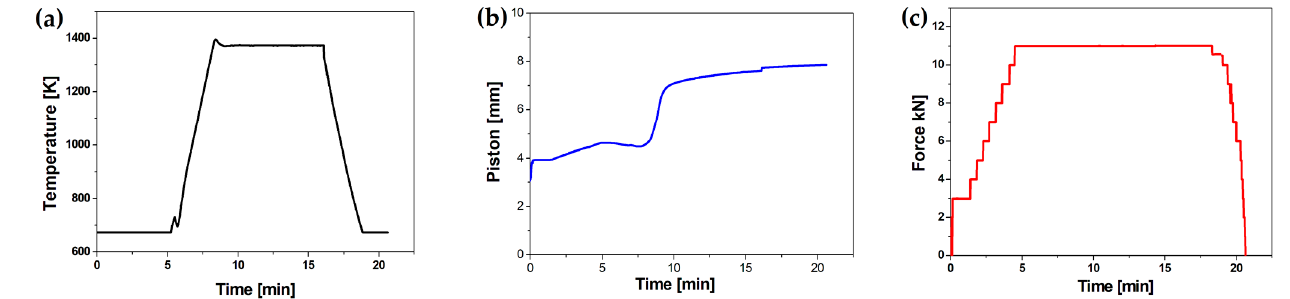
Figure 1. SEM images of raw materials. ( a ) 316L austenitic stainless steel, ( b ) diboride zirconium, and ( c ) diboride titanium.